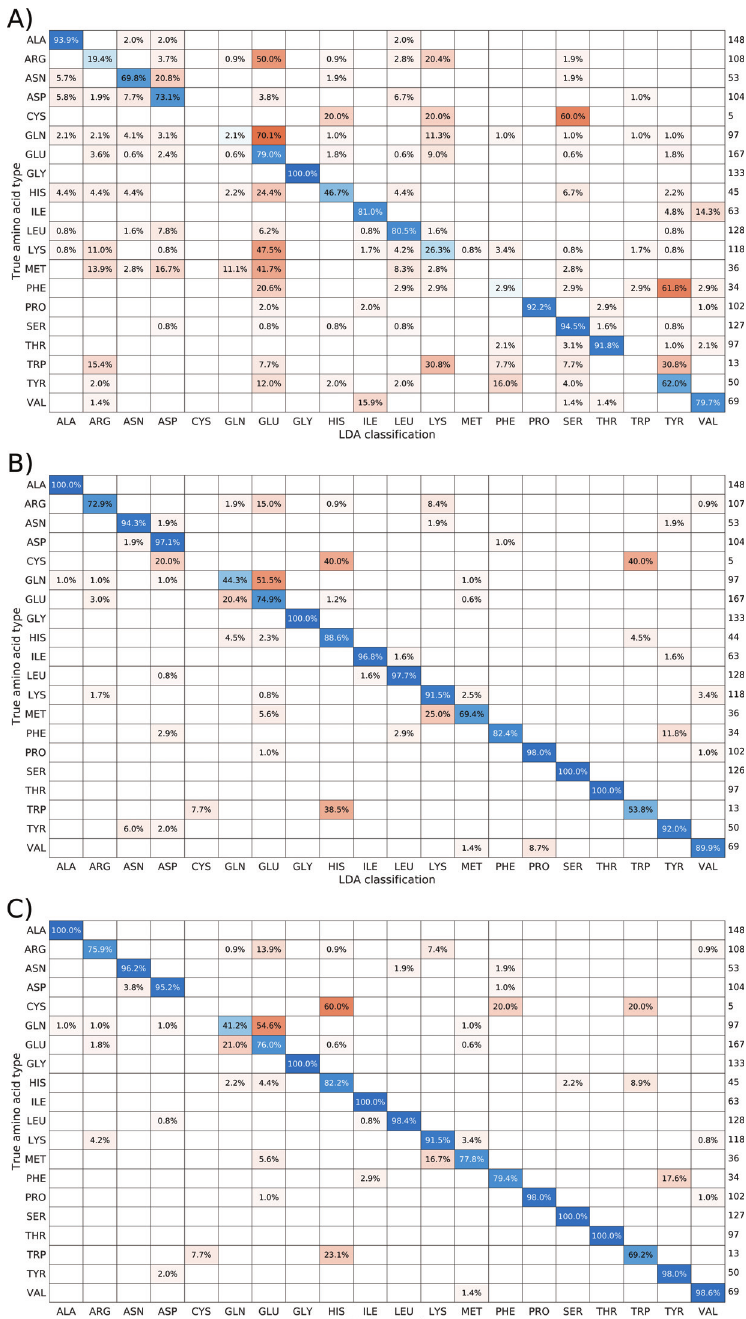
Fig 5. Confusion charts for the proposed chemical shift sets. The charts result from performing leave-one-out cross- validation of the 17 proteins from the BMRB used for training. Diagonal elements (in blue) represent correct classifications, and non-diagonal elements (in red) represent incorrect classifications. The values listed to the right of each chart are the sum, for all 17 proteins used, of residues of a given type that were classified. The charts are “row normalized”, that is to say, each row shows the distribution of how true amino acid types were classified. Weighted mean accuracy (weighted by the number of residues in the proteins) was calculated for each case: A) subset (i), 66.94%; B) subset (ii), 88.67%; and C) subset (iii),